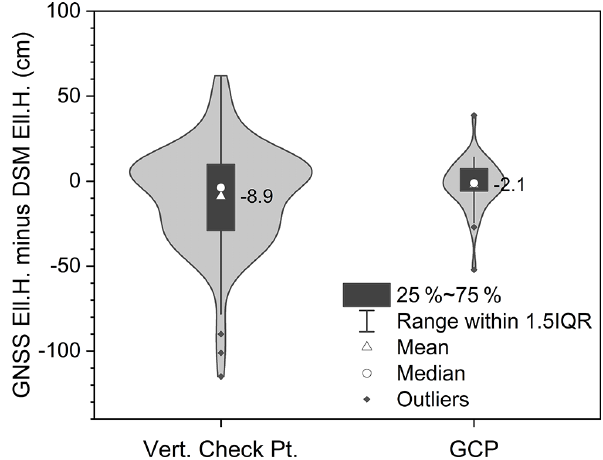
Figure 9. Difference between GNSS ellipsoid height and 14 August DSM ellipsoid height for 109 check points and 37 GCPs. Negative values indicate that DSM elevation is greater than GNSS-surveyed elevation. Mean difference (cm) is shown in the plot. The curve rep- resents the kernel-smoothed frequency distribution of vertical dif- ferences.